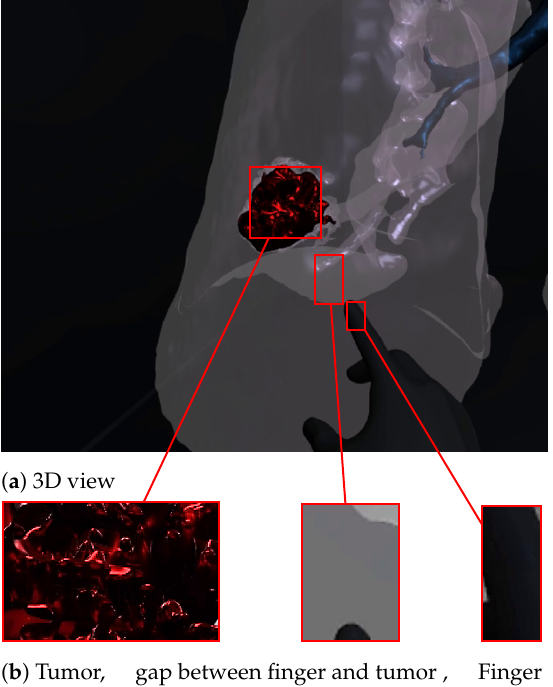
Figure 7. Virtual reality viewer of the tumor before touching